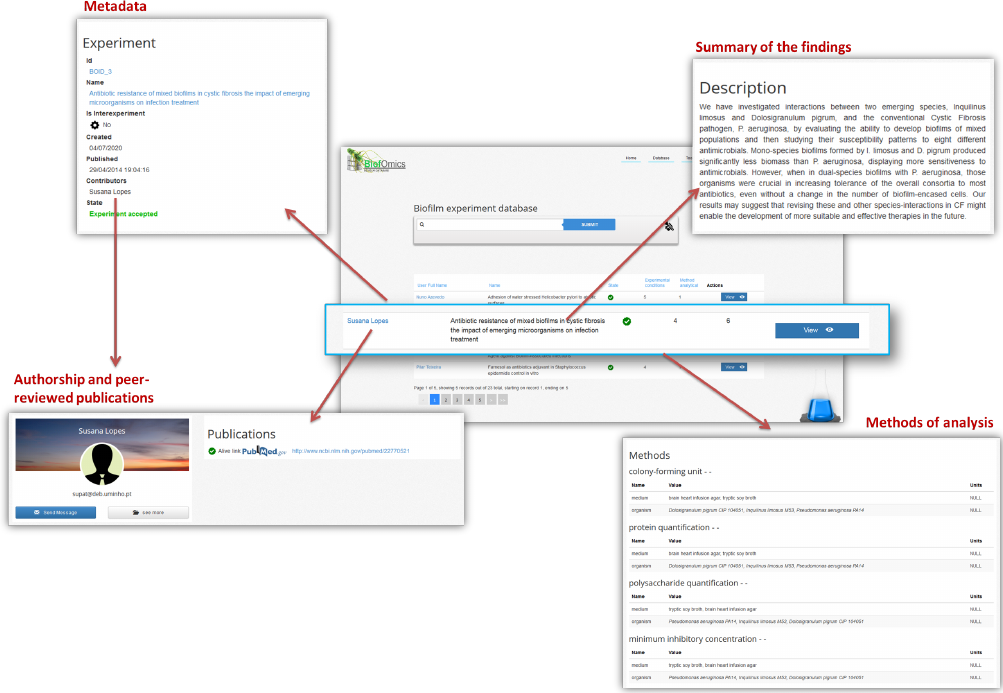
Figure 5: Example of the annotation of BiofOmics database records with the Biofilms ontology. The annotation includes the study design, authorship information and any related peer reviewed publications, and metadata and data